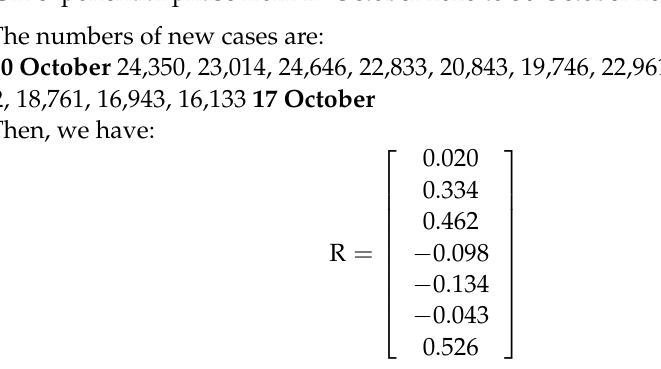
Figure A6. Values of the daily reproduction numbers R j along the period of contagiousness of length 7 days.